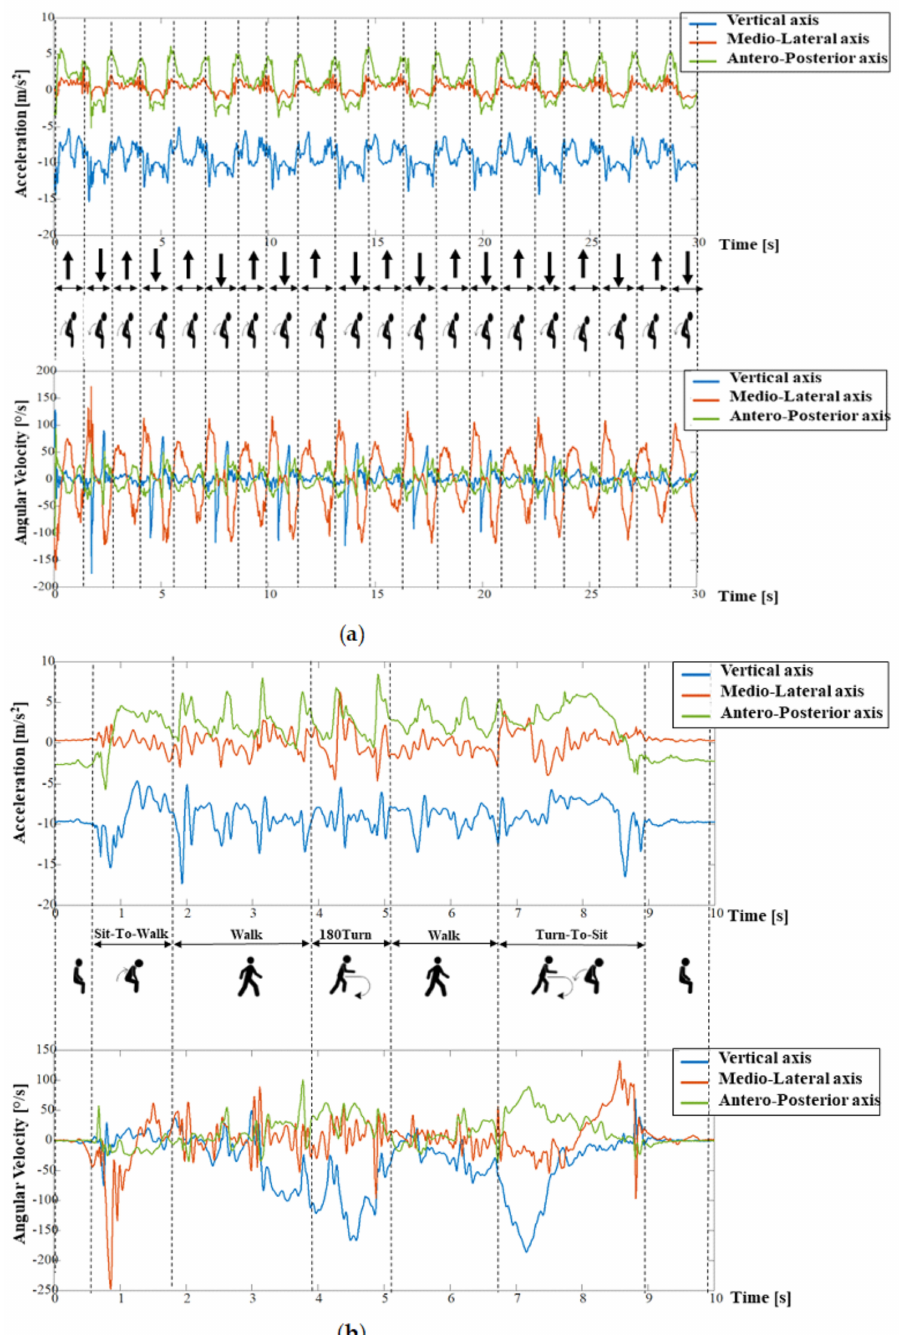
Figure 1. Time series of acceleration and angular velocity of the two instrumented physical performance tests. ( a ) Time series of acceleration and angular velocity over the Sit-to-Stand ( ↑ ) and Stand-to-Sit ( ↓ ) subphases of the 30CST and ( b ) time series of acceleration and angular velocity over the subphases of the TUG